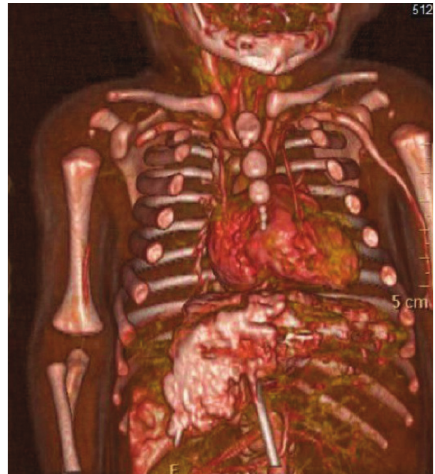
Figure 2: Three-dimensional view on computed tomography angiography showed right axillary artery occlusion from its first part till brachial artery in mid arm with no evidence of collaterals, consistent with a diagnosis of right axillary artery